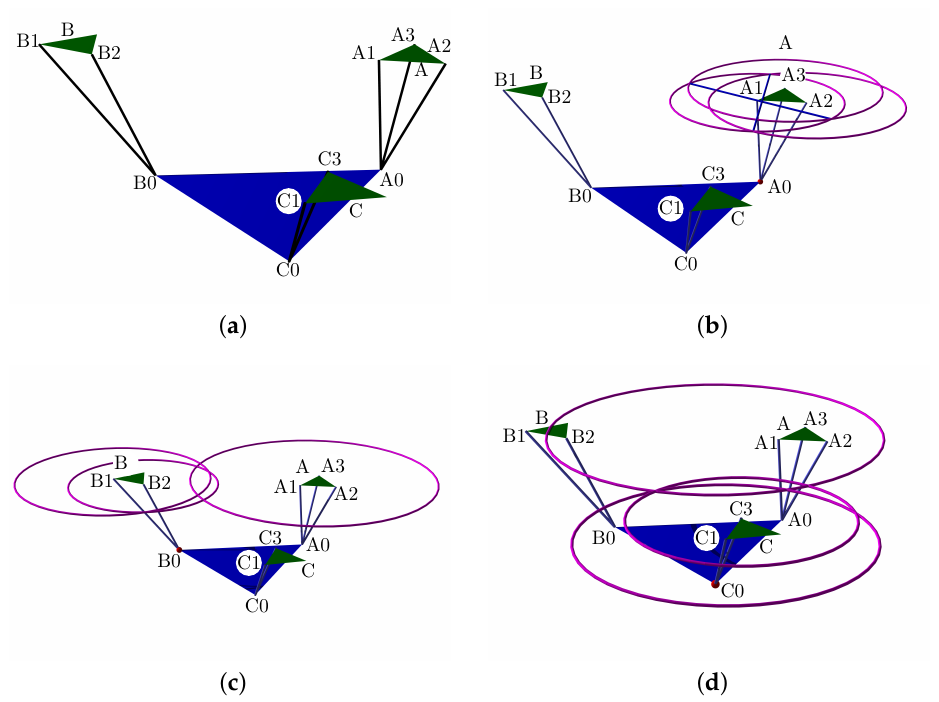
Figure 14. Computed positions from sensor lengths at portable configuration: ( a ) the rest position, ( b ) apex A, ( c ) apex B, and ( d ) apex